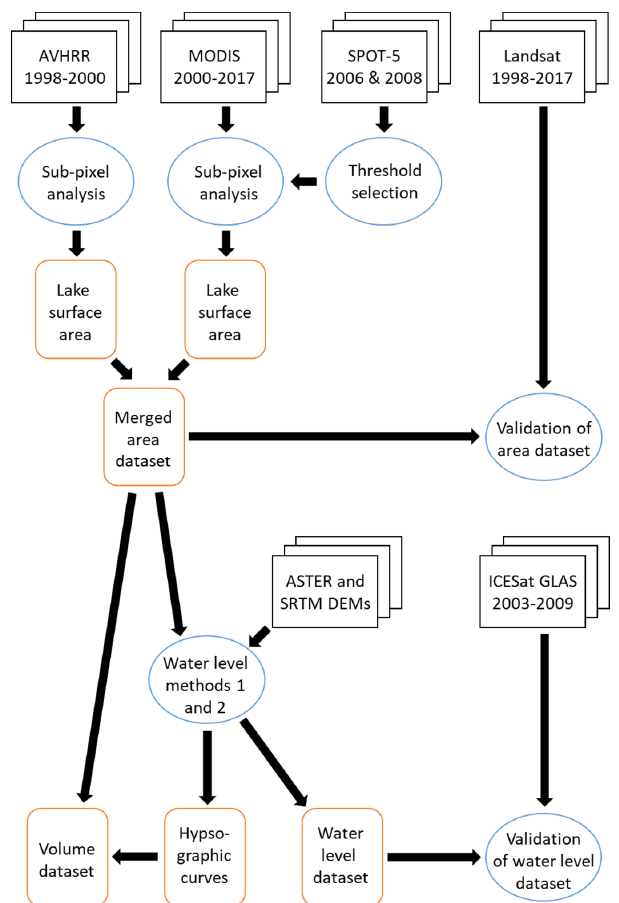
Figure 4. Schematic diagram of the data and methods used in this study.